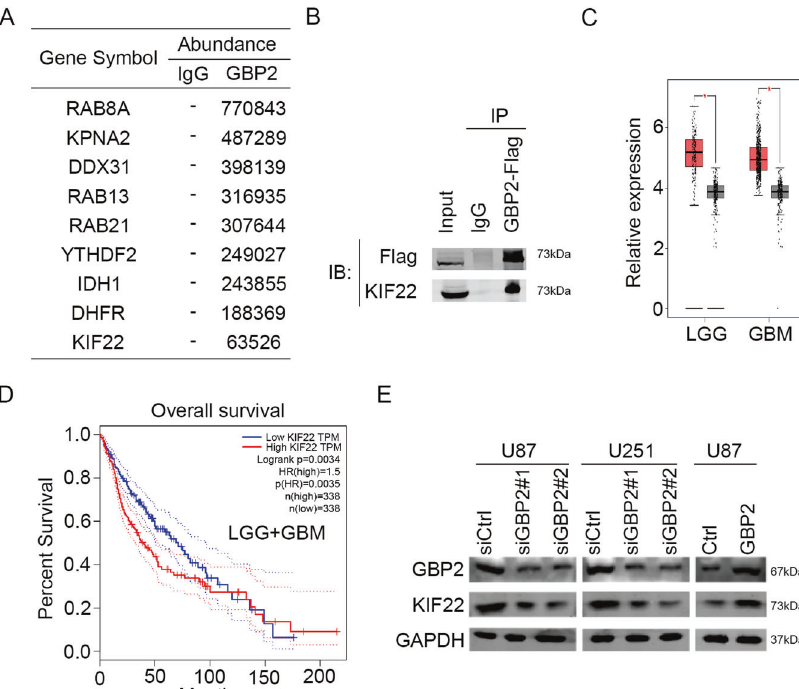
Fig. 5 GBP2 interacts with KIF22 and regulates KIF22 expression. A Proteins with large differences in expression levels between control and GBP2-overexpressing cells. B Co-immunoprecipitation results showing the interaction between GBP2 and KIF22. C Analysis of KIF22 expression in GBM and LGG from TCGA database. D Overall survival in patients with different KIF22 expression levels. E Western blotting results showing that GBP2 regulates the expression level of KIF22. Each experiment repeated as least 3